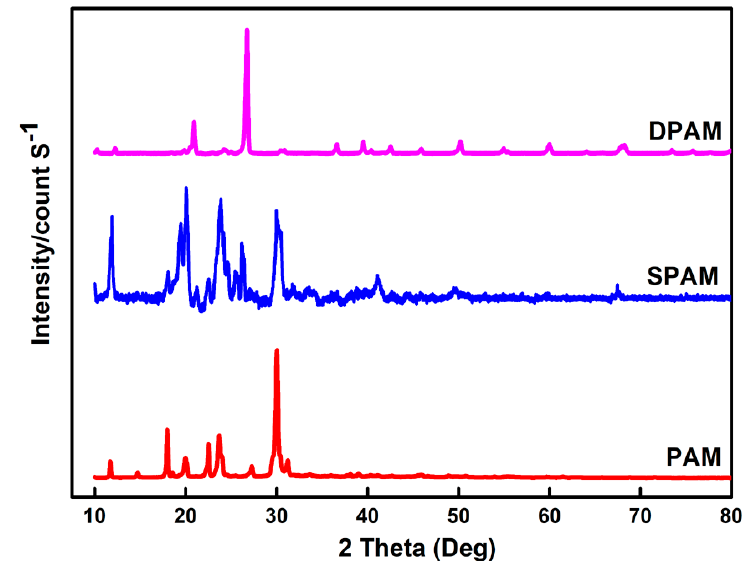
Figure 6. XRD pattern of PAM, SPAM, and DPAM.